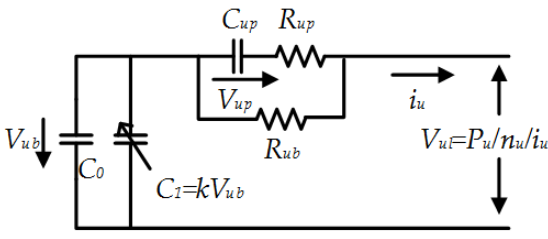
Figure 3. UC equivalent circuit model.